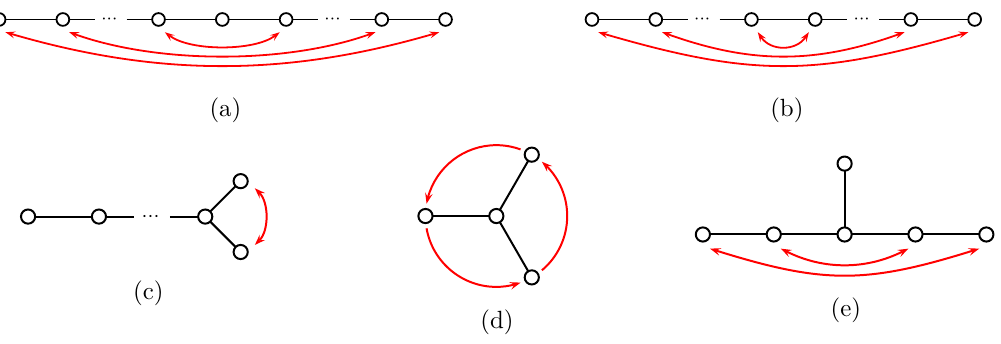
Figure 19. Dynkin diagrams and graph outer automorphisms of simple Lie algebras of type (a) A 2 n +1 , (b) A 2 n , (c) D n , (d) D 4 and (e) E 6 .